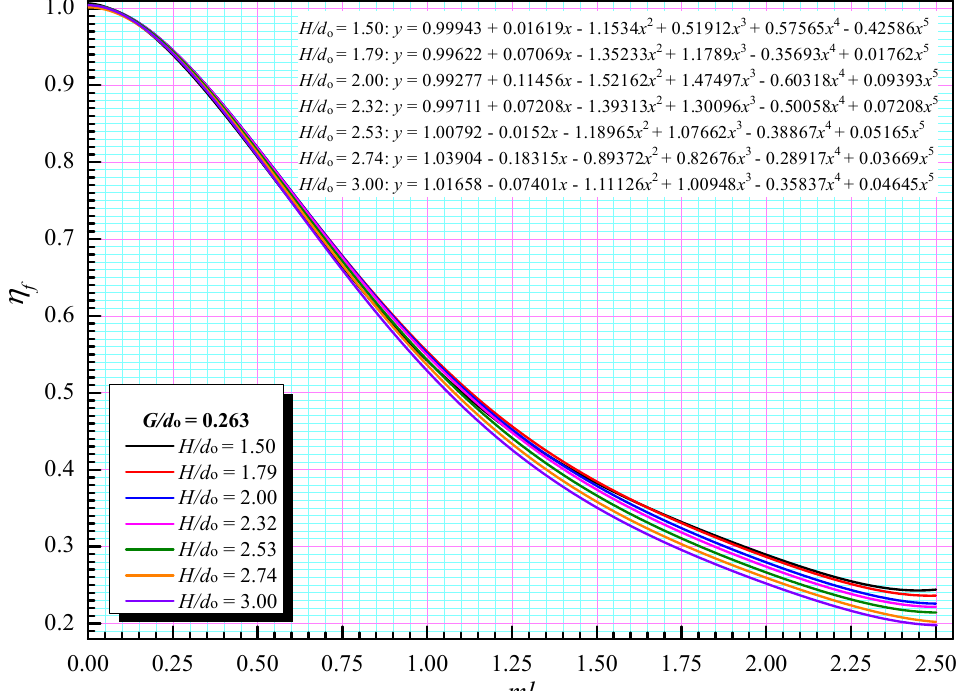
Figure 7. Linear nomograms and fitting formulae of fin efficiency at G / d o = 0.263.